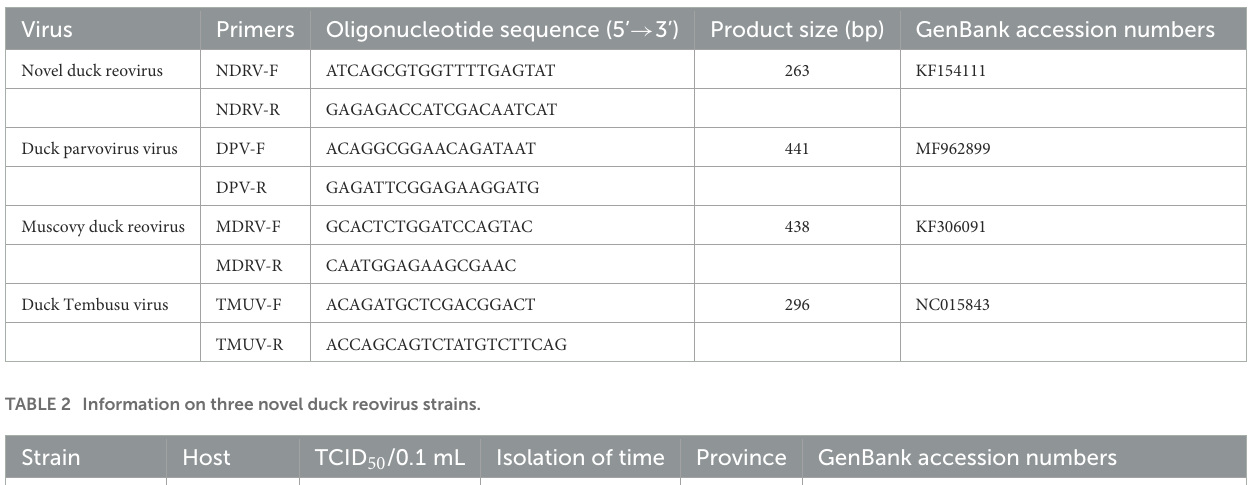
TABLE 1 Primers used in this study.